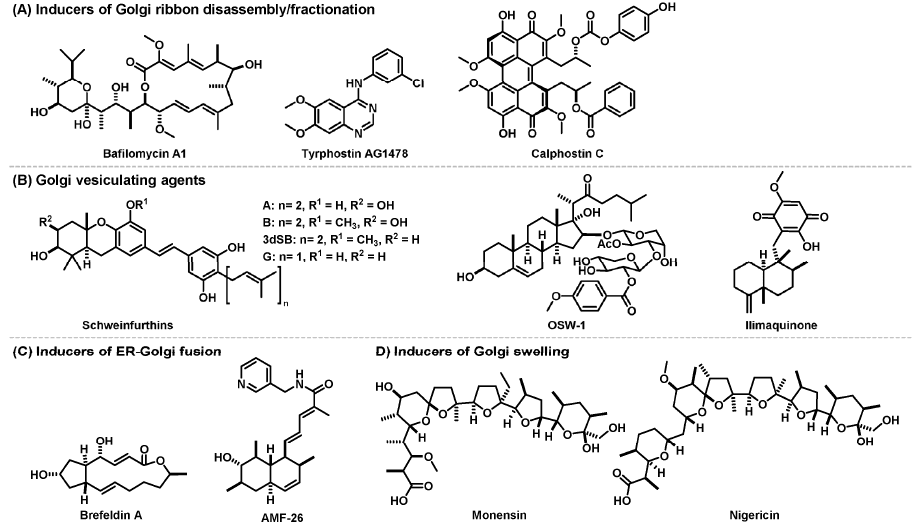
Figure 3. Anticancer natural products that disrupt structural organization of Golgi apparatus.